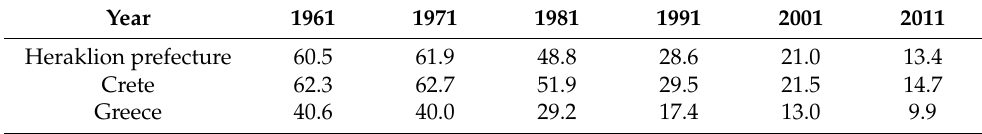
Table 2. Occupation in agriculture, fisheries and forestry as % of economically active population.